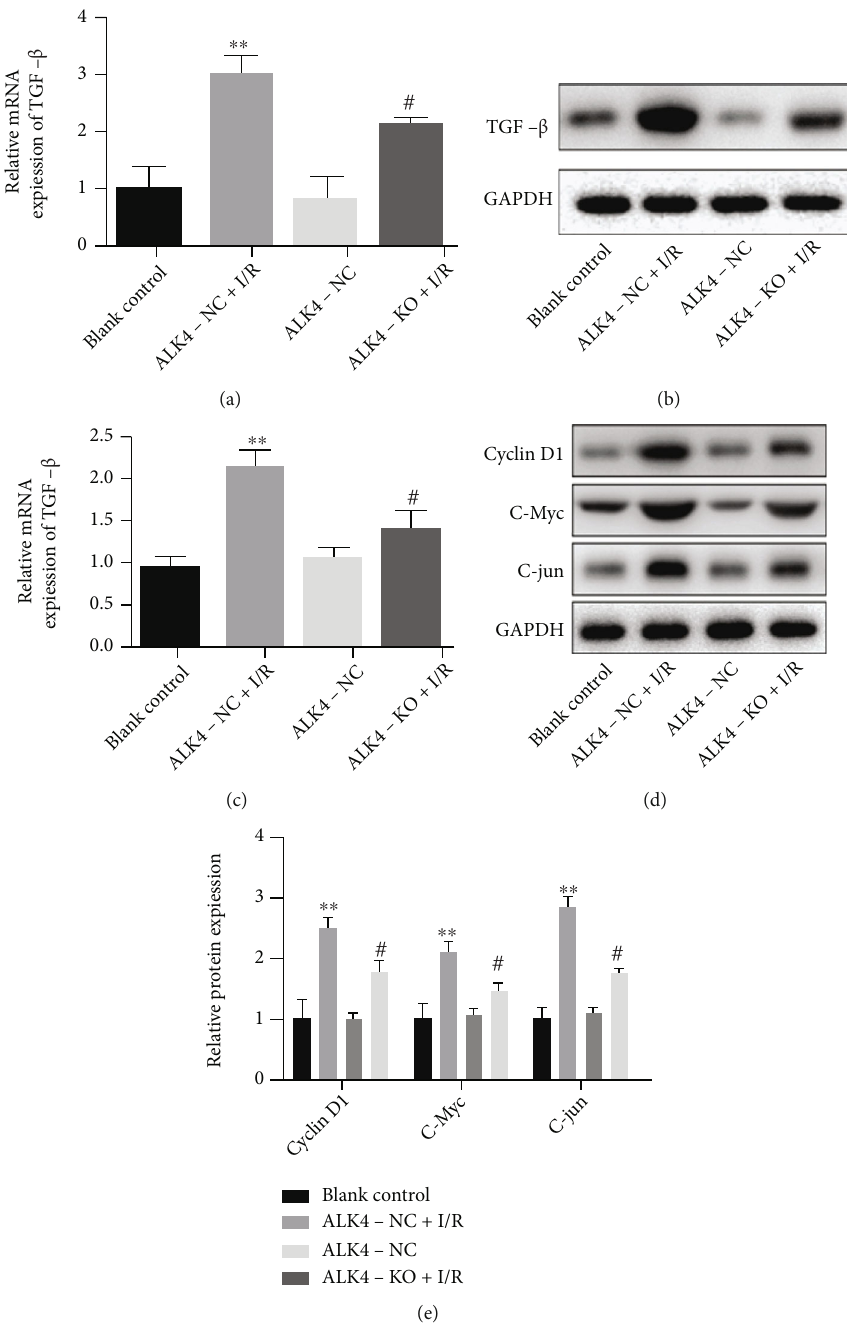
Figure 5: E ff ects of ALK4 on the expression of molecules related to TGF- β signaling pathway. (a – c) mRNA (PCR) and protein (Western blotting) expressions of TGF- β in di ff erent groups. (d and e) Expression of Cyclin D1, c-Myc, and c-Jun was in fl uenced by I/R injury and ALK4 (Western blotting). Data are presented as mean ± SD . ∗ P < 0 : 05 , ∗∗ P < 0 : 01 , and ∗∗∗ P < 0 : 001 , ALK4-NC+I/R group vs. ALK4-NC group. # P < 0 : 05 , ## P < 0 : 01 , and ### P < 0 : 001 , ALK4-KO+I/R group vs. ALK4-NC+I/R (Figure 4(h)), and caspase-3 and Bax (Figures 4(i) and 4(j)) dramatically reduced at 24 h after I/R in the cells with down- regulation of ALK4 expression. These results indicated that downregulation of ALK4 expression improves myocardial I/R injury in vitro . (Figure TNF- α (Figure 4(g)), IL-1 β